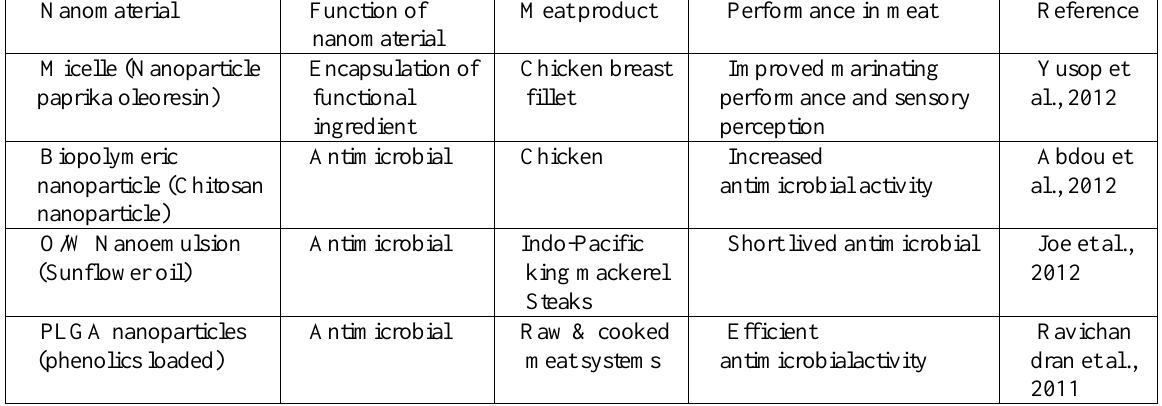
Table 2. Nan materials for delivery of functional ingredients in meat